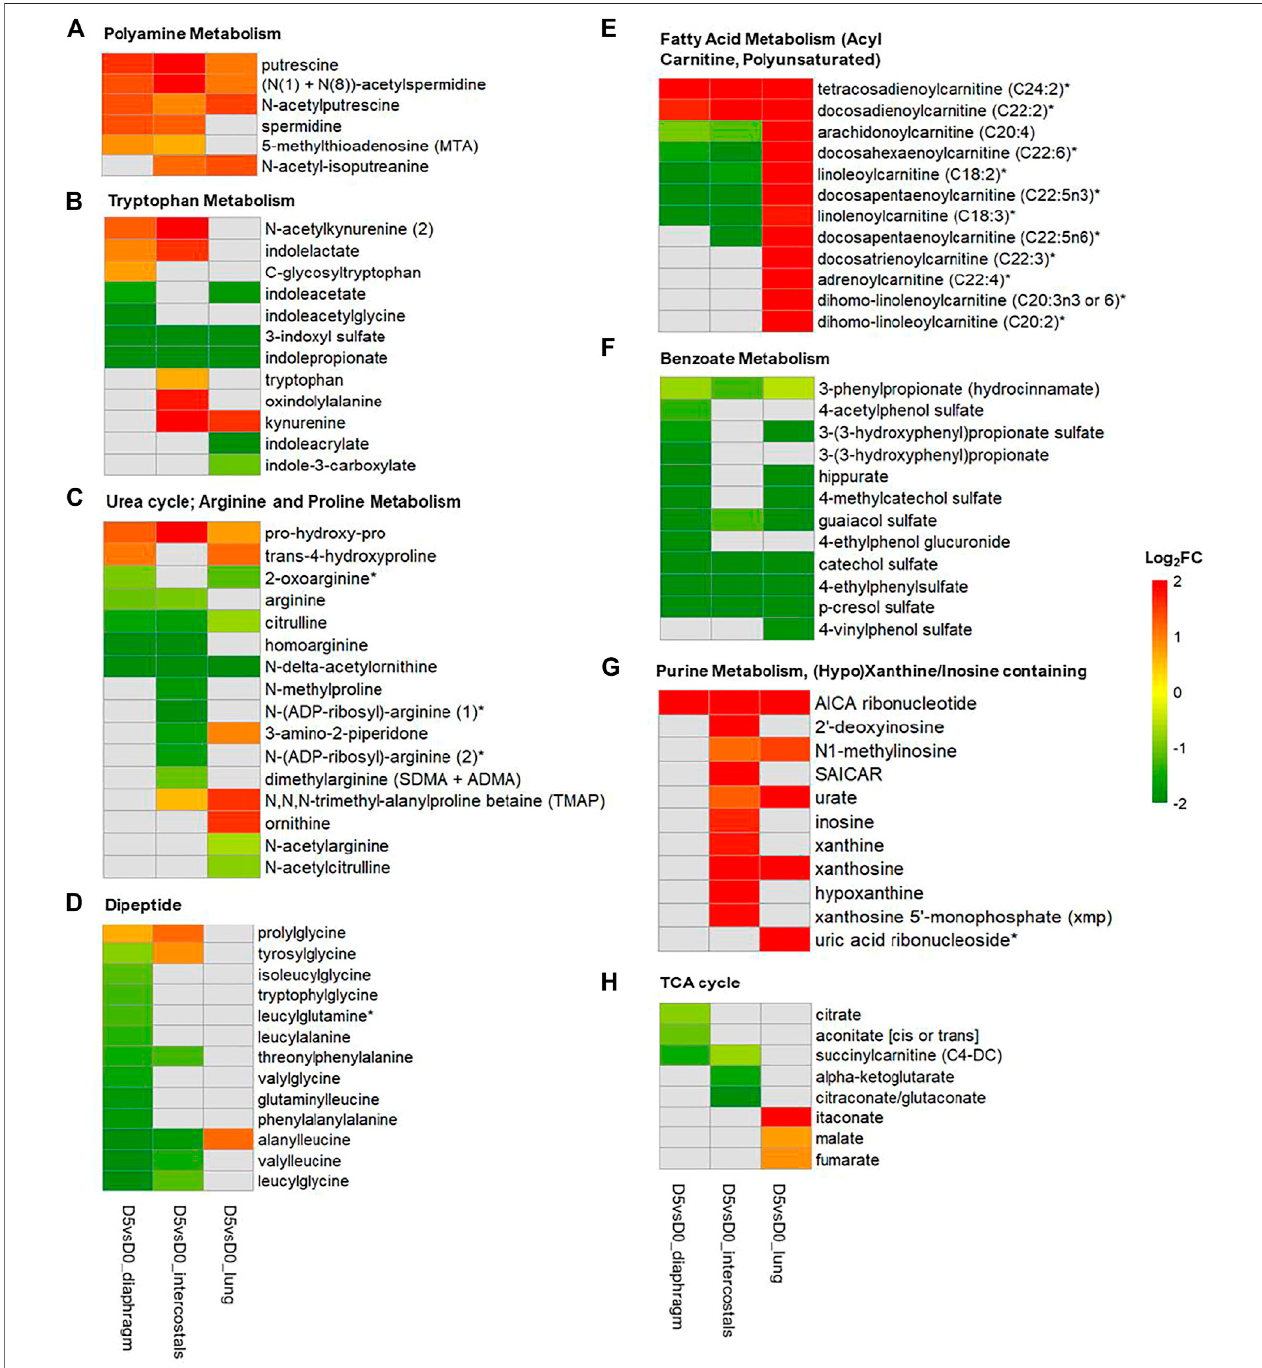
FIGURE 7 | Heatmap of DMs involved in metabolomic signature pathways of all three tissues. (A) Polyamine Metabolism; (B) Tryptophan Metabolism; (C) Urea cycle; Arginine and Proline Metabolism; (D) Dipeptide; (E) Fatty Acid Metabolism (Acyl Carnitine, Polyunsaturated); (F) Benzoate Metabolism; (G) Purine Metabolism, (Hypo)Xanthine/Inosine containing; (H) TCA cycle. Color scale bar represents Log 2 (FC).